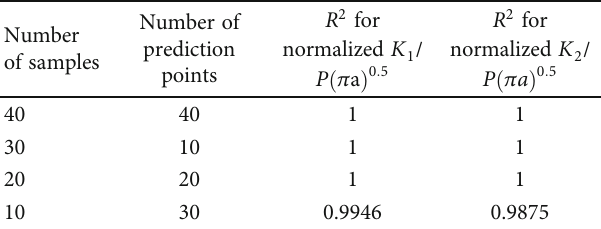
Figure 6: Curve graph of normalized SIFs and numerical solution under di ff erent training points. (a) The normalized SIFs K varies with the crack angle under di ff erent training points. (b) The normalized SIFs K di ff erent training points. Table 1: Comparison of the accuracy results of four di ff erent